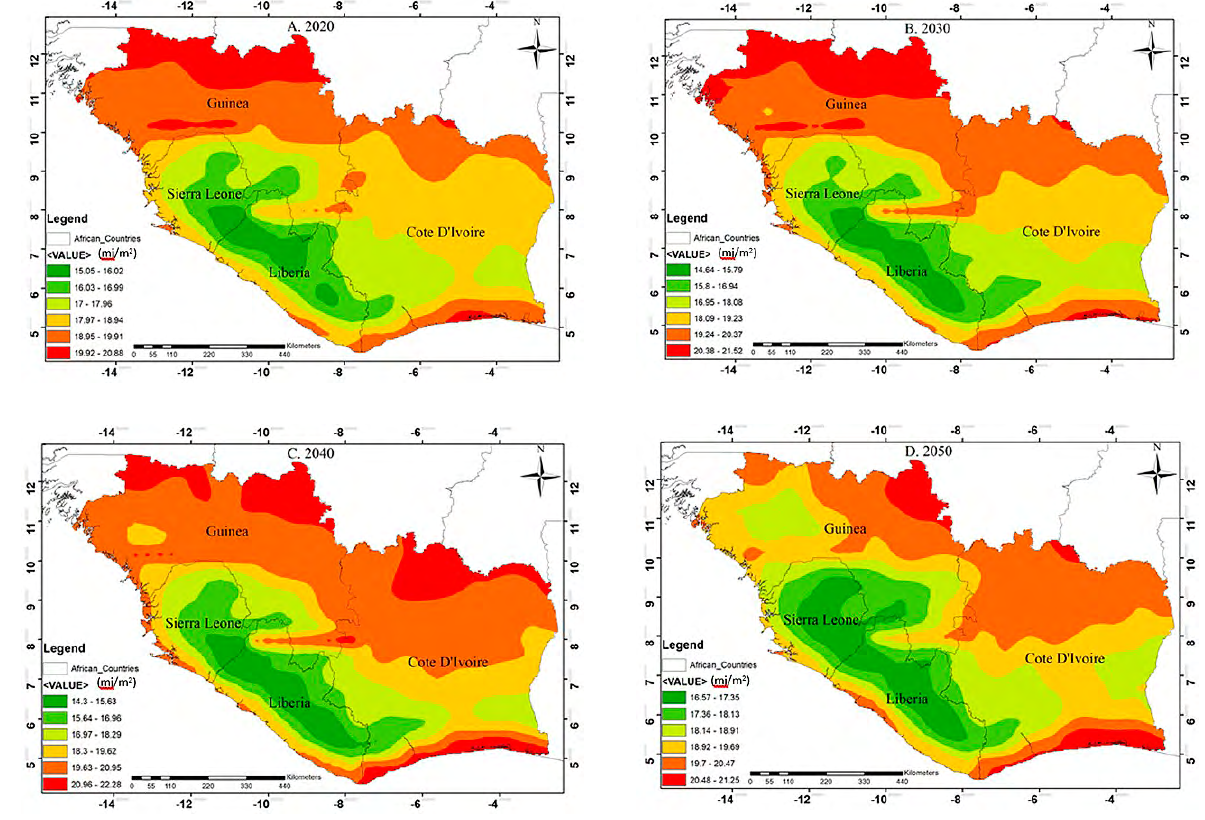
Figure 7. Decadal Spatial Distribution of Solar Radiation (mj/m 2 ) in the MRU region for the period